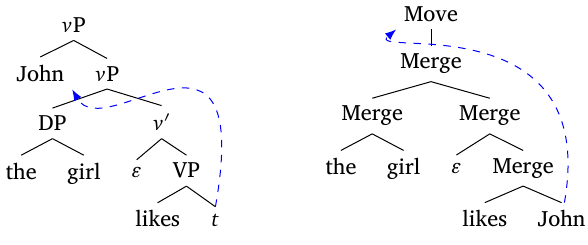
Figure 3: Phrase structure tree and derivation tree after the first movement step; dashed arrows are not part of the